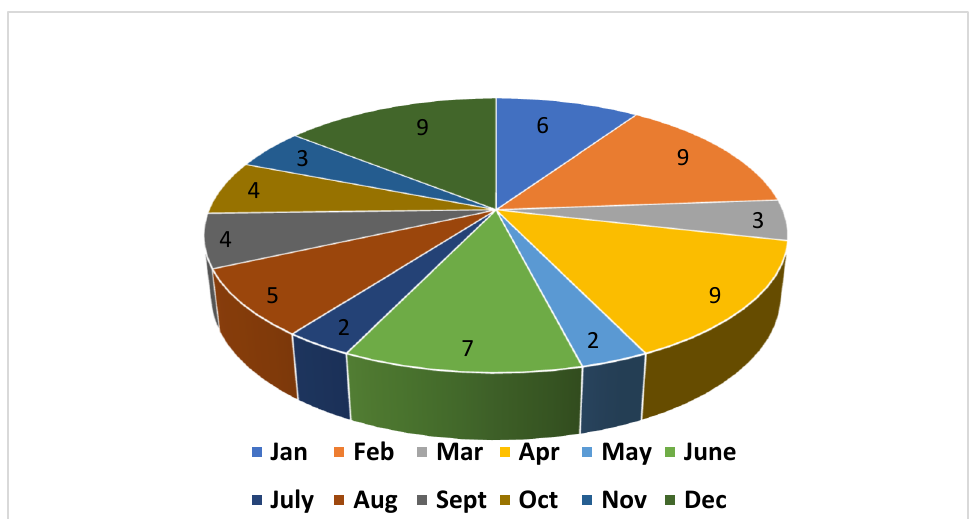
Figure 6. Number of the days with precipitation.